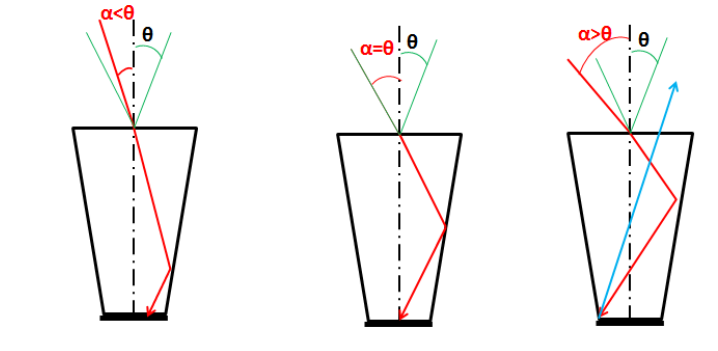
Figure 4. Beam path as a function of its incidence angle.